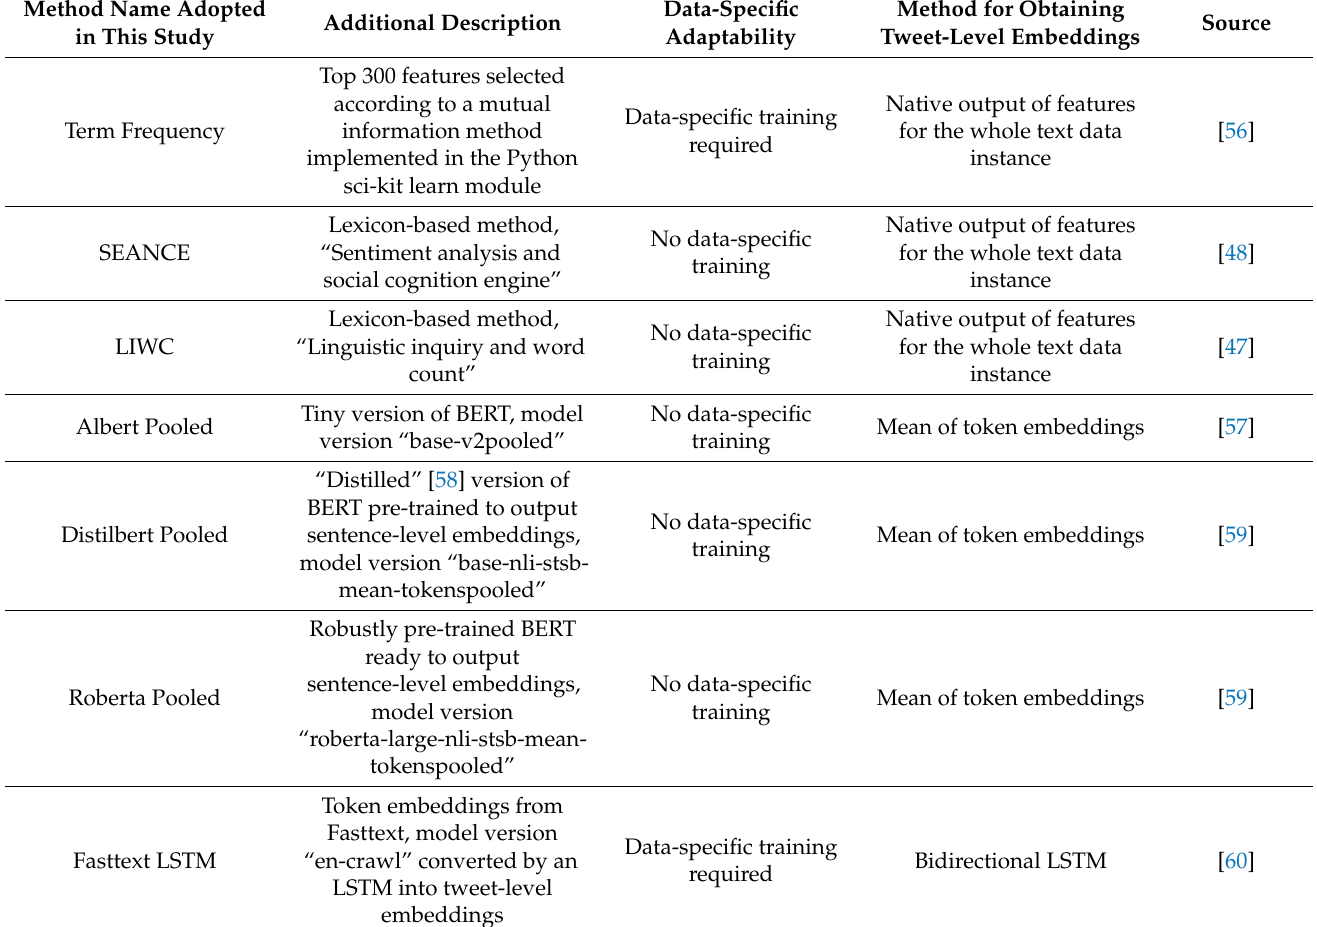
Table 2. List of the feature extraction methods used in our